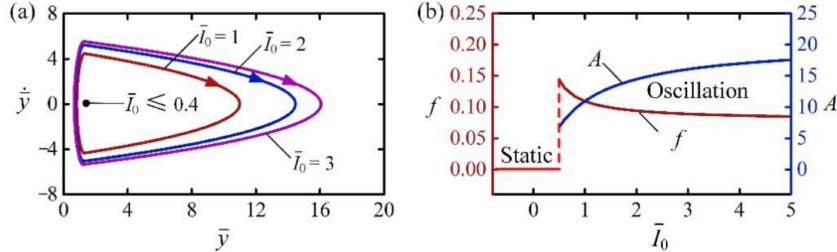
Figure 6. The effect of light intensity on the self-jumping, for C 0 = 0.3, H = 4, β = 0.01, g = 1, . = 0.001, E = 500, y = 30, and = 0. ( a ) Limit cycles. ( b ) Frequency and amplitude. n g = 0.4, p y am 0 0 With the increase of I 0 , the frequency of self-jumping decreases, while the amplitude increases.